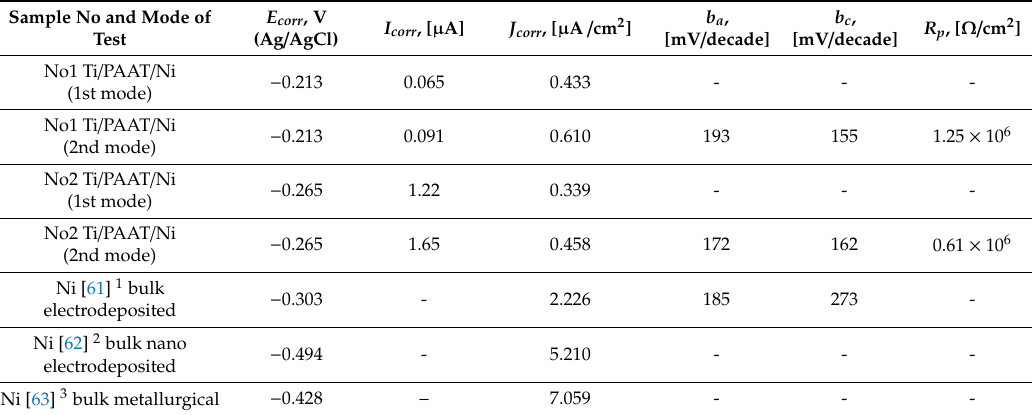
Table 3. The Ti / PAAT / Ni nanocomposite corrosion parameters, determined by two ways: the polarization curves extrapolation (mode 1) and using the polarization resistance (mode 2). E corr , V Sample No and Mode of Test (Ag /